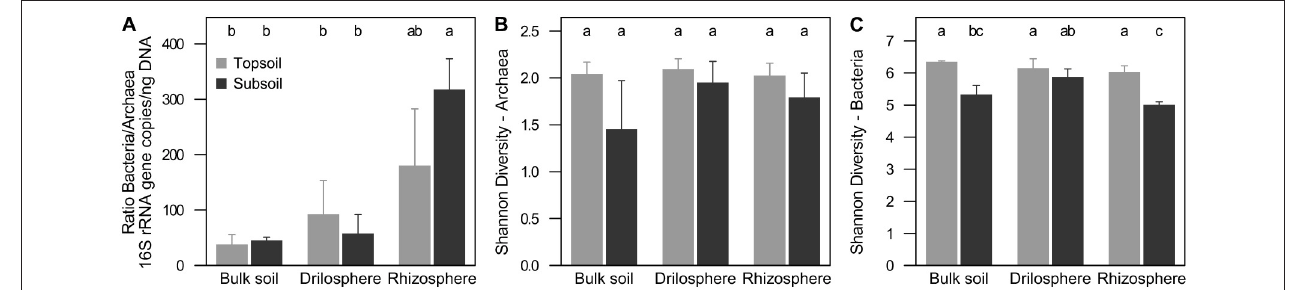
FIGURE 1 | Relation of 16S rRNA copies between archaea and bacteria (A) and Shannon diversity index at 90% similarity level of archaea (B) and bacteria (C) in soil compartments of topsoil and subsoil. Different letters indicate significant differences ( P ≤ 0.05).